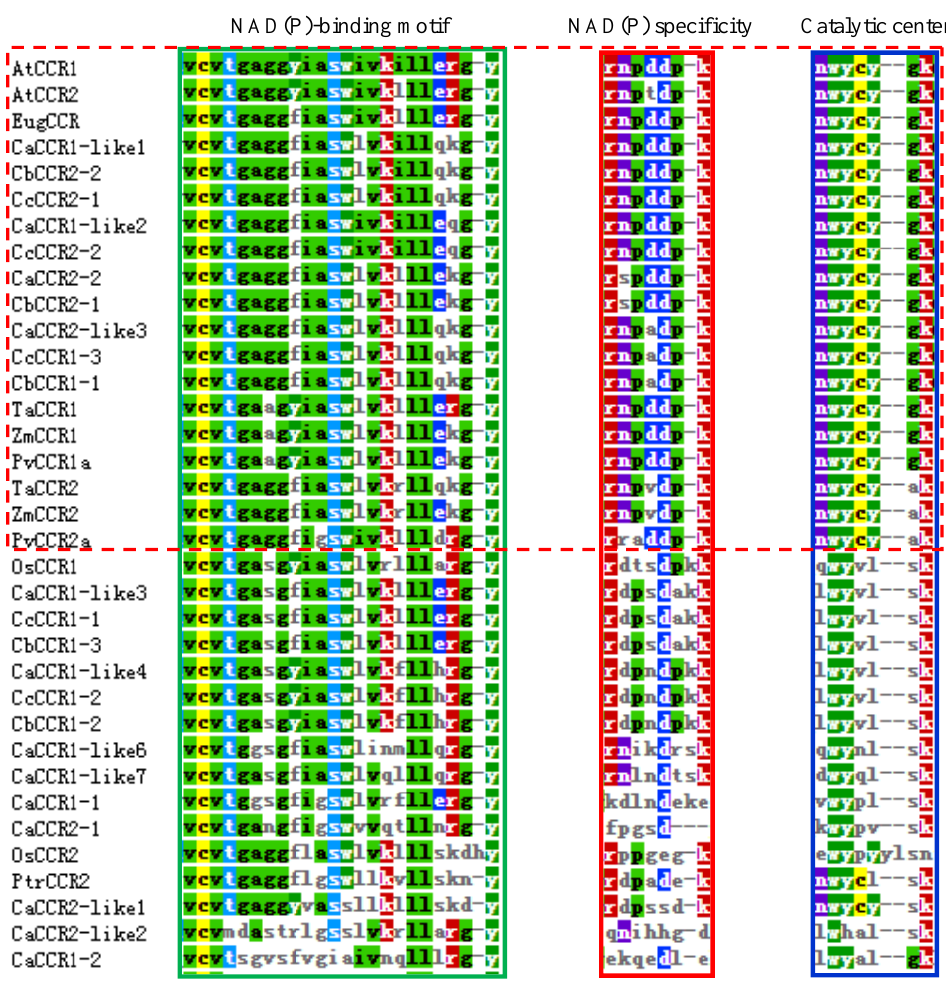
Figure 4. Multiple alignments of the NAD(P)-binding, NADP specificity, and CCR catalytic motifs of pepper CCRs with functional CCRs from other plant species. Amino acid sequences were aligned using Clustal-W. Colored amino acids denote identical or similar amino acids. NAD(P)-binding and NADP specificity motifs are boxed in green and red, respectively. The catalytic signature motif of CCRs is boxed in blue. A. thaliana CCRs ( AtCCR1 , AAG46037; AtCCR2 , AAG53687); O. sativa ( Os- CCR1 , XP_015621618.1; OsCCR2 , XP_025883369.1); H. vulgare CCR ( HvCCR , AAN71760); P. virgatum CCRs ( PvCCR1a , GQ450297; PvCCR2a, GQ450302); T. aestivum CCRs ( TaCCR1 , ABE01883; TaCCR2 , AY771357); Z. mays CCRs ( ZmCCR1 , CAA74071; ZmCCR2 , NP_001005715); P. trichocarpa ( PtCCR2 , XP_002300619.2); E. gunnii ( EugCCR , CAA56103.1).